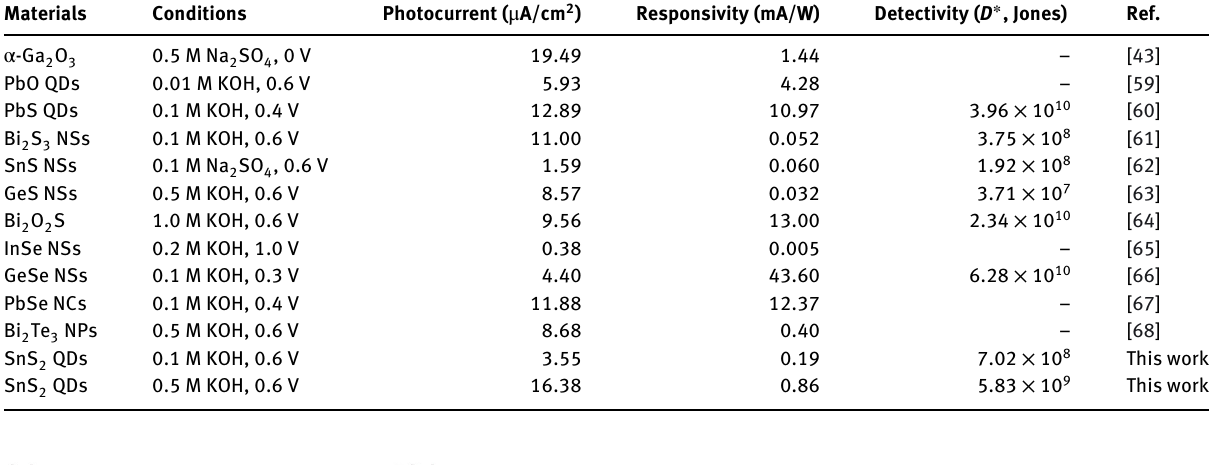
Table 1: The comparison of the SnS 2 QDs-based PDs and other previously reported PEC-type photodetection. Materials